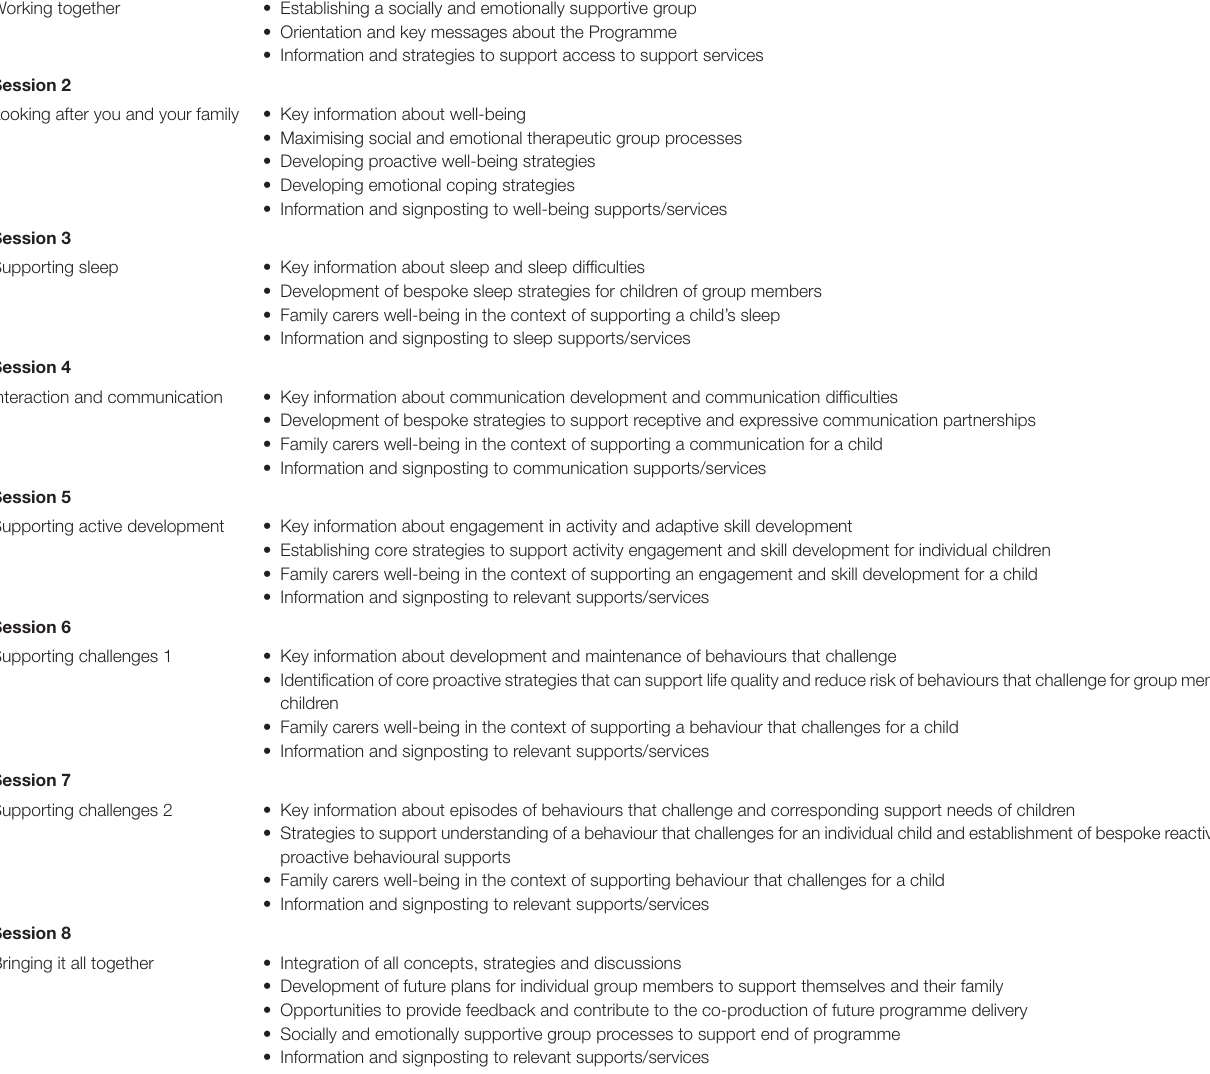
TABLE 1 | Content of the Early Positive Approaches to Support (E-PAtS) Programme